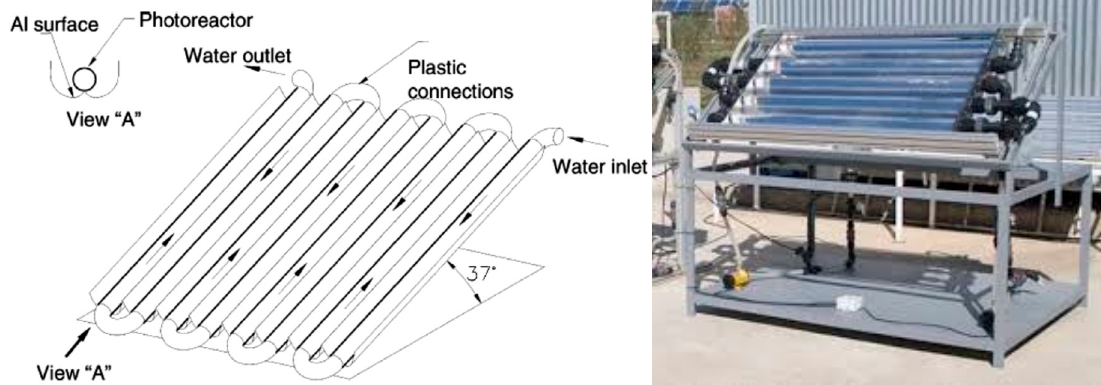
Figure 2. Schematic drawing and picture of a compound parabolic collector [27,45].